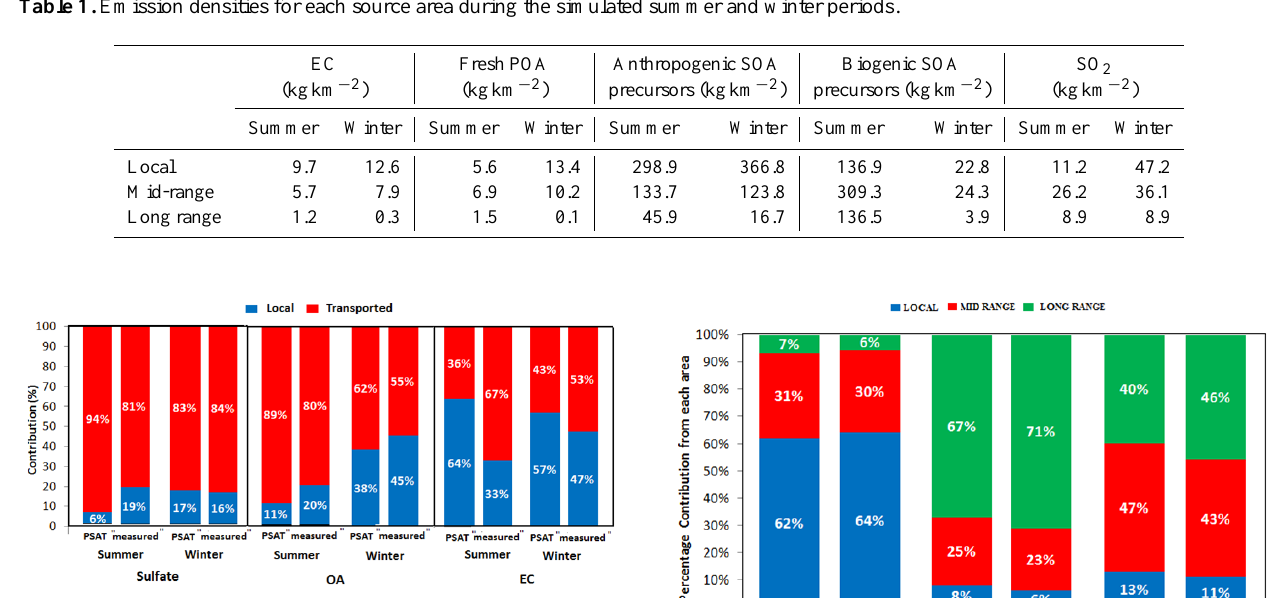
Table 1. Emission densities for each source area during the simulated summer and winter periods.